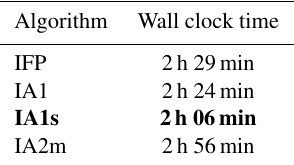
Table 6. Computing time (wall clock) for the processing of 1-year of global data (ECMWF test data used in this paper) with the old IFP algorithm and the new IA1, IA1s, and IA2m algorithms, on single thread. The fastest algorithm is marked in